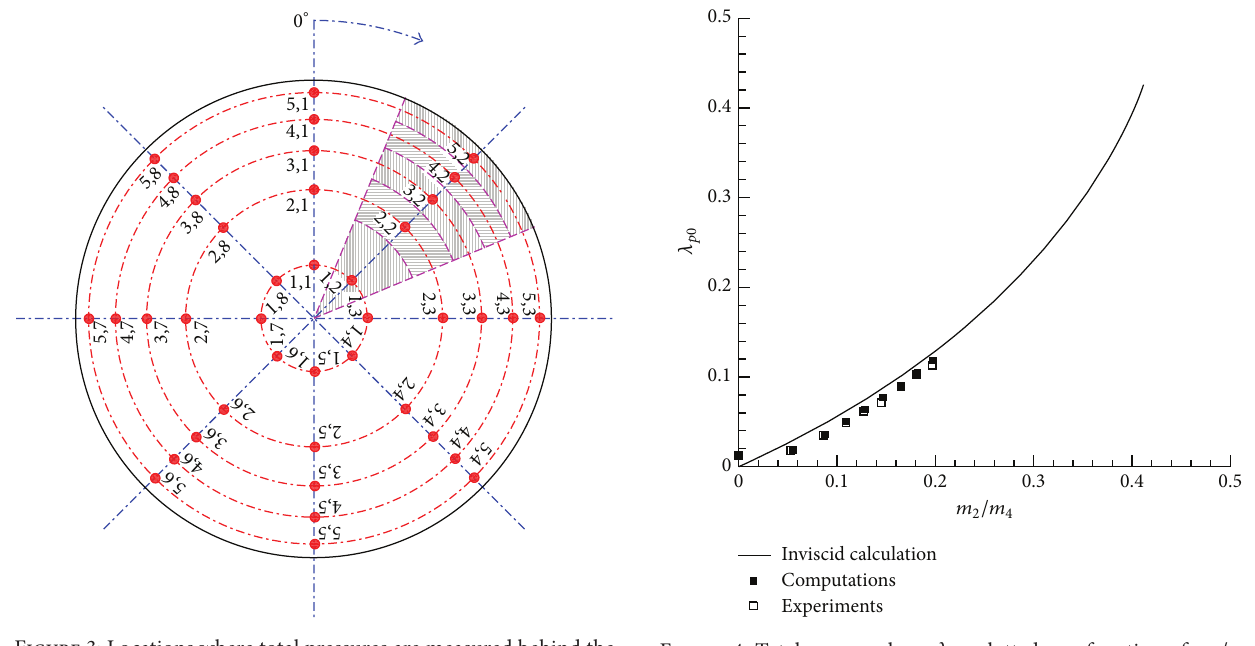
, plotted as a function of 𝑚 2 /𝑚 4 ; p 0